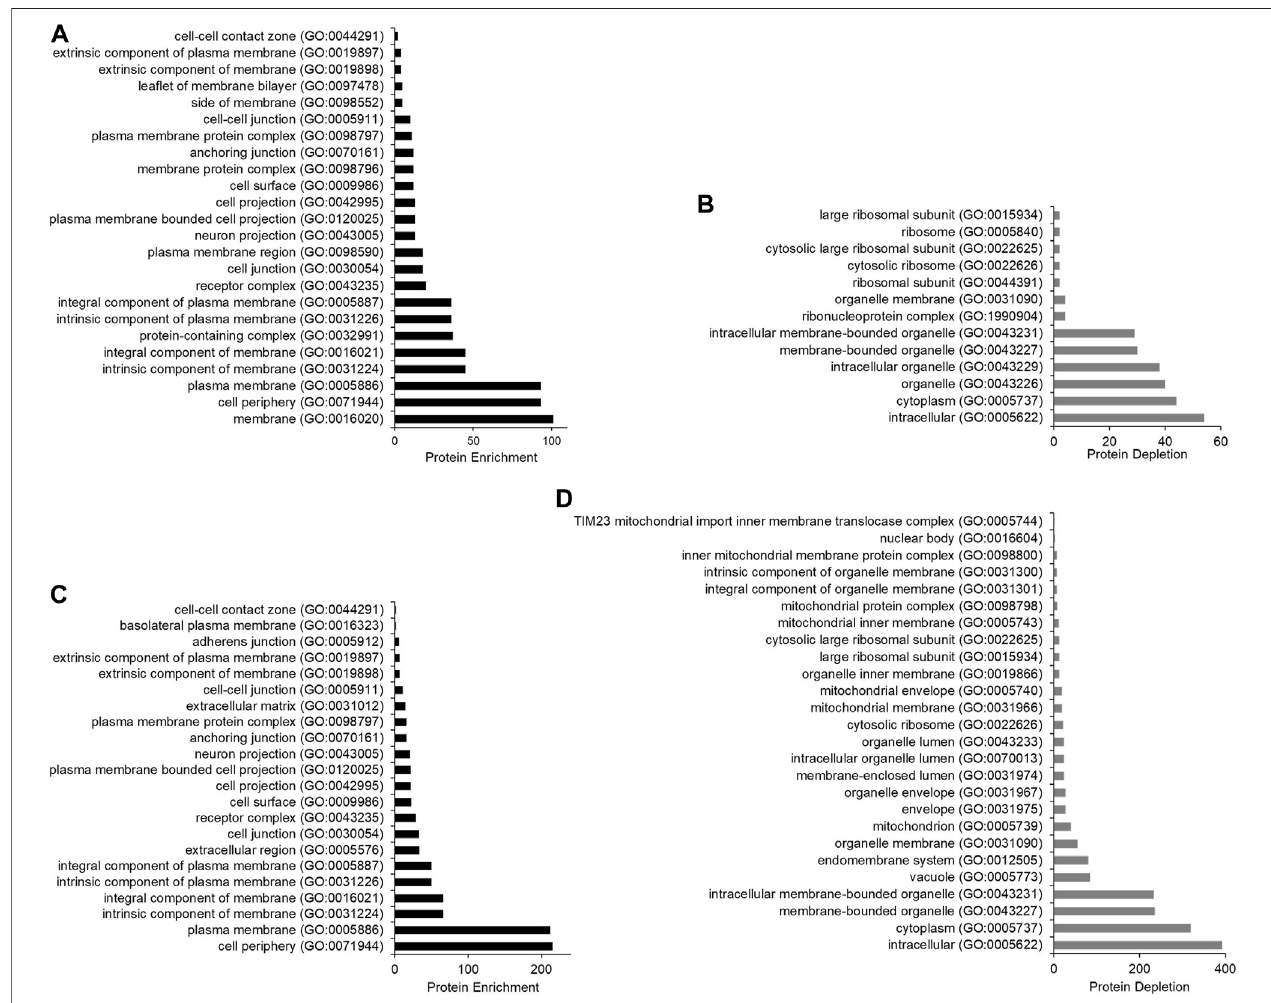
FIGURE 6 | Bar chart to show the protein enrichment from samples extracted using SMA and RIPA (wash protocol 3). Gene Ontology analysis was conducted using the PANTHER statistical enrichment test (Mi et al., 2021). (A) protein enrichment analysis for samples extracted with SMA; (B) protein depletion analysis for samplesextractedwithSMA. (C) proteinenrichmentanalysisforsamplesextracted withRIPA; (D) protein depletionanalysisforsamplesextractedwithRIPA.Allcellular components underwent statistical analysis via Fisher ’ s exact test. Only cellular components found statistically signi fi cant are shown ( p- value < 0.05).